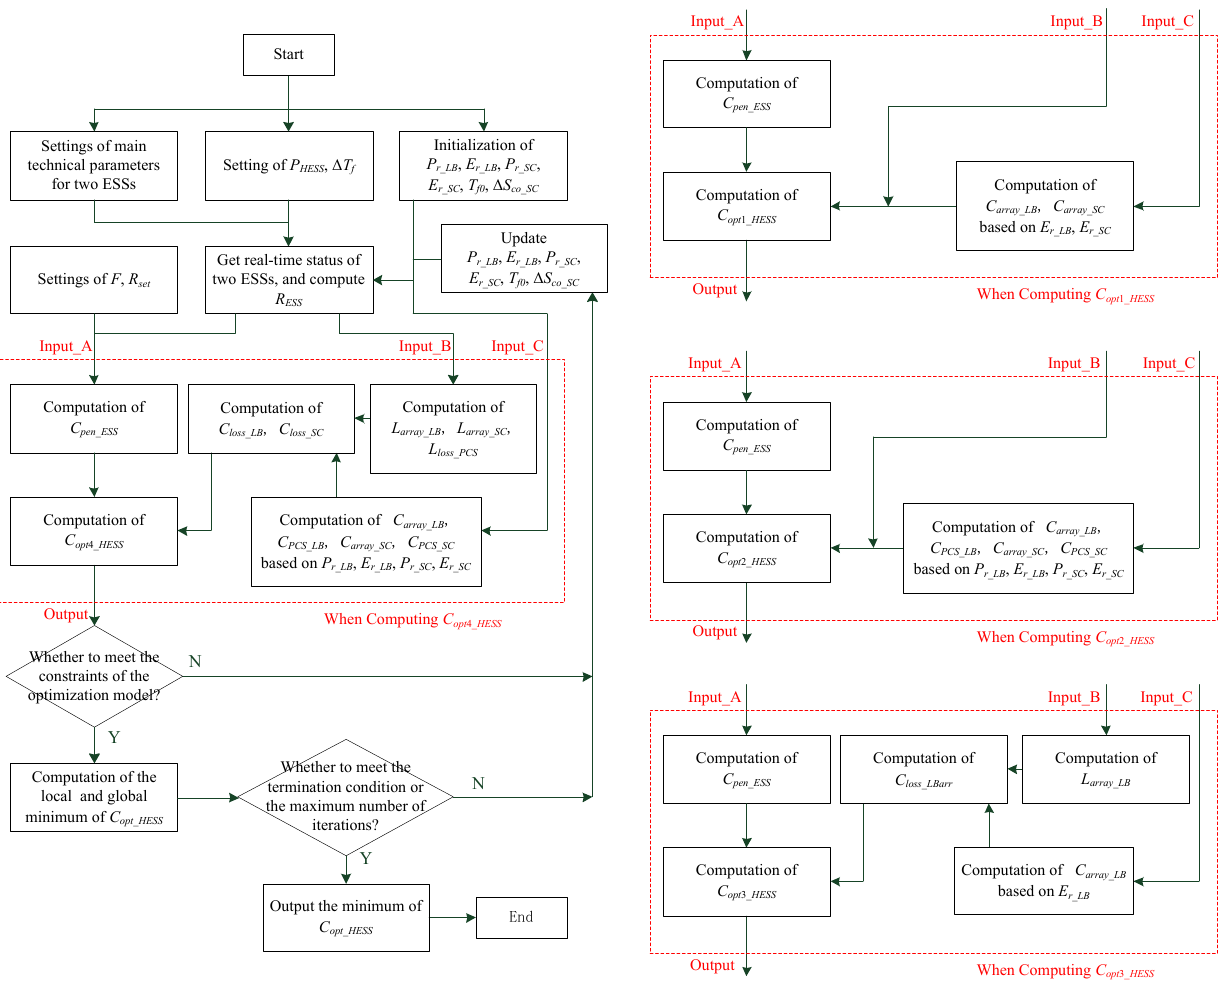
Figure 4. Flowcharts of algorithm for impact analysis models of Different Considerations in Cost and